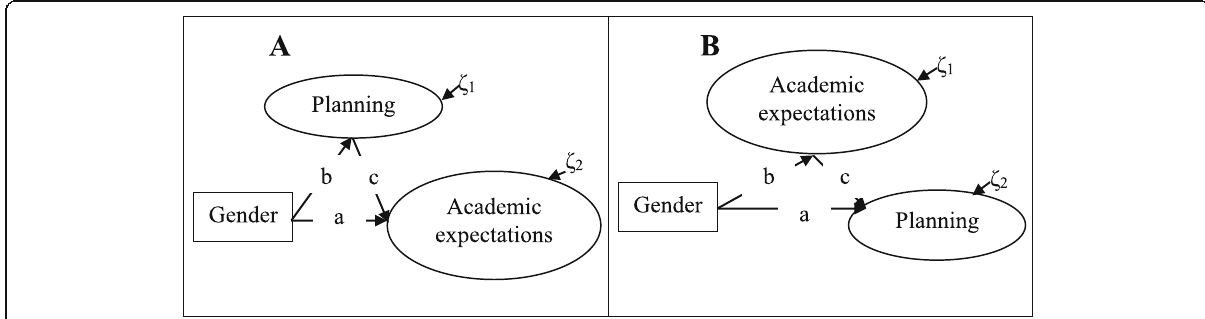
Fig. 1 Alternative mediation models. Conceptual diagrams for planning as mediator in A and for academic expectations as mediators in B . a = direct effect of the observed predictor (OP) on the latent criterion (LC); b = direct effect of the OP on the latent mediator (LM); c = direct effect of the LM on the LC; b × c = indirect effect of the OP on the LC; a + (b × c) = total effect; ζ = structural residuals, random disturbances, or amount of mediators ( ζ 1 ) and criteria ’ s ( ζ 2 ) variance not accounted by